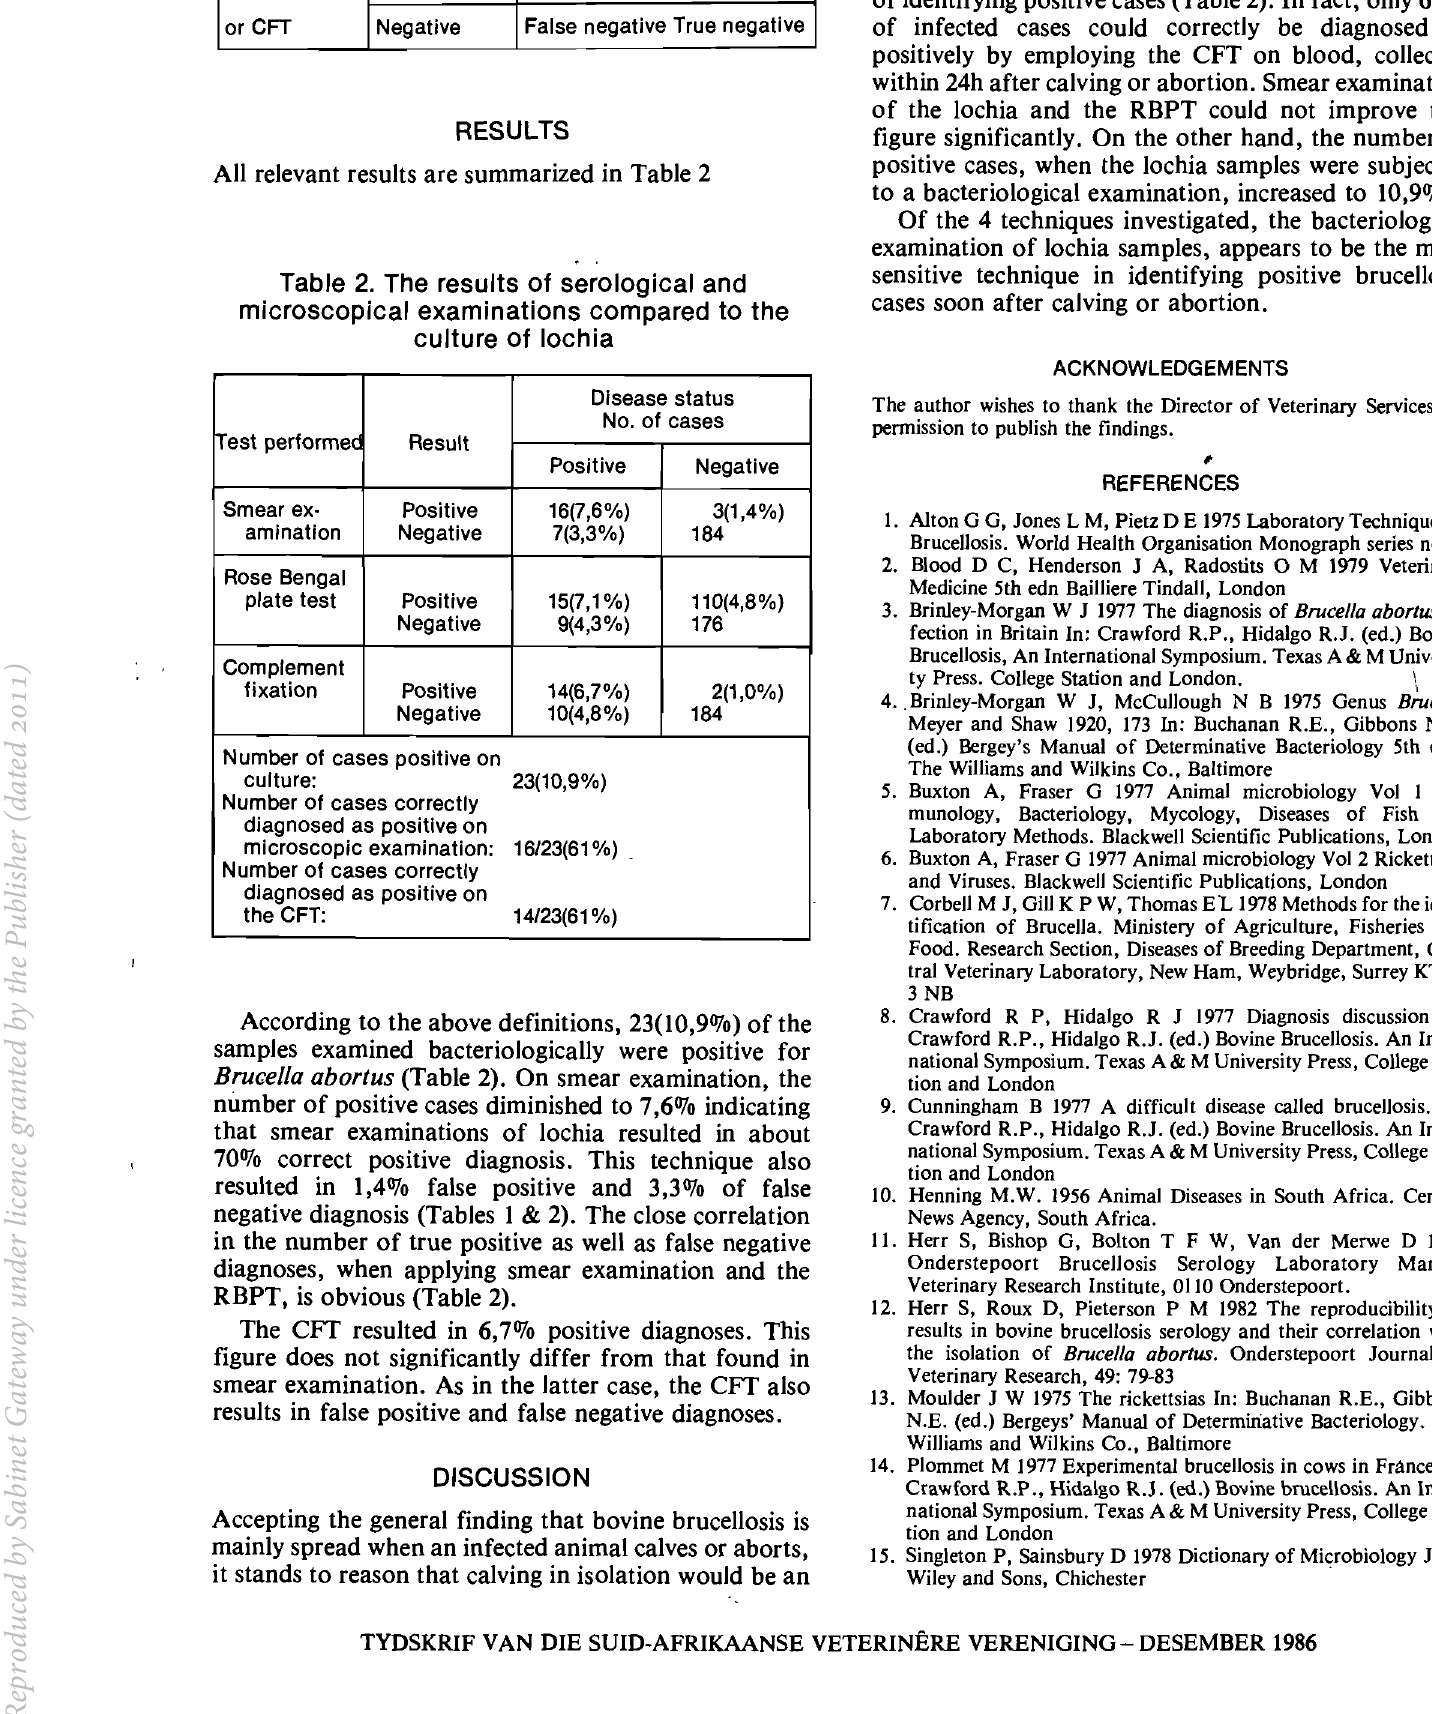
Table 1. Definition of disease status based on bacteriological, microscopical and serological